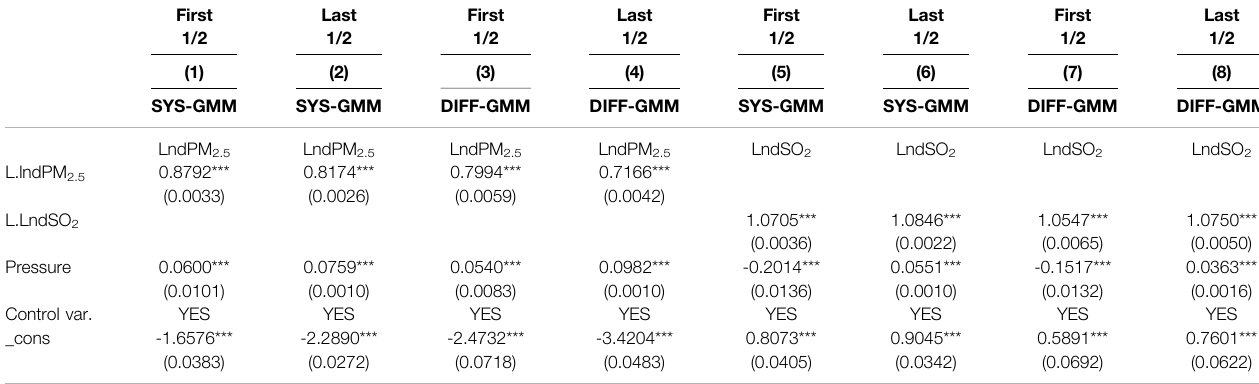
TABLE 4 | In fl uence of different fi nancial pressure intensities on air pollution emissions in resource-dependent